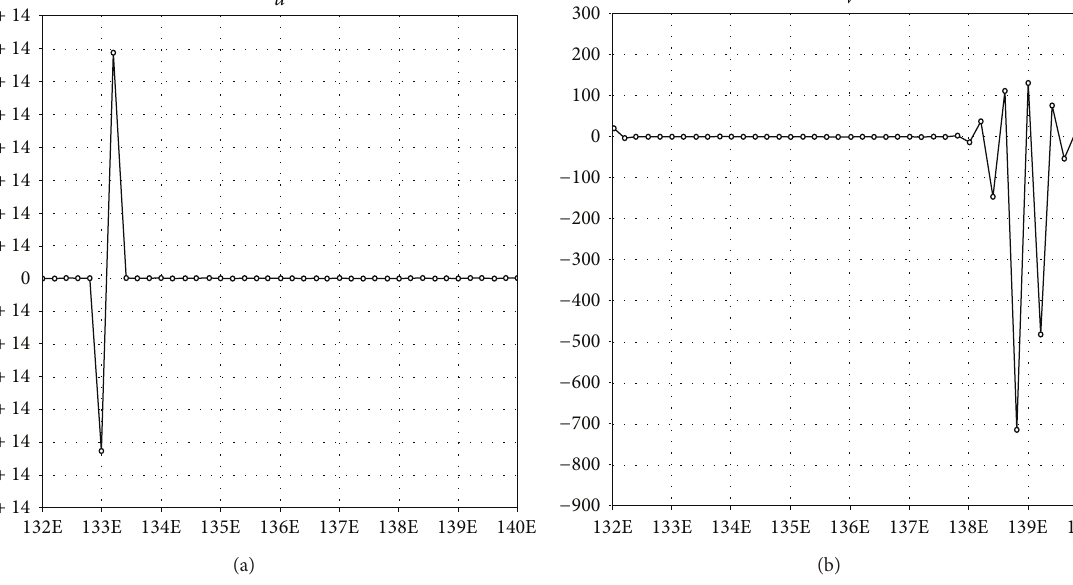
Figure 4: The figures show the values of the zonal velocity 𝑢 and the meridional velocity V at the latitude 29 ∘ N after a time integration of 5